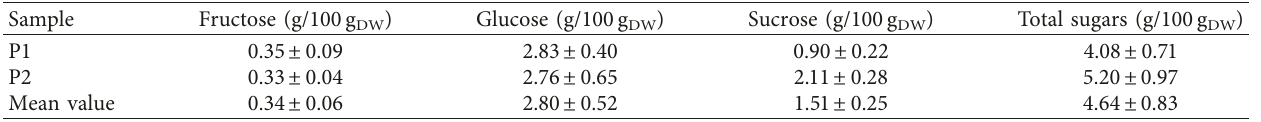
Table 7: Sugar content of dried breadfruits.